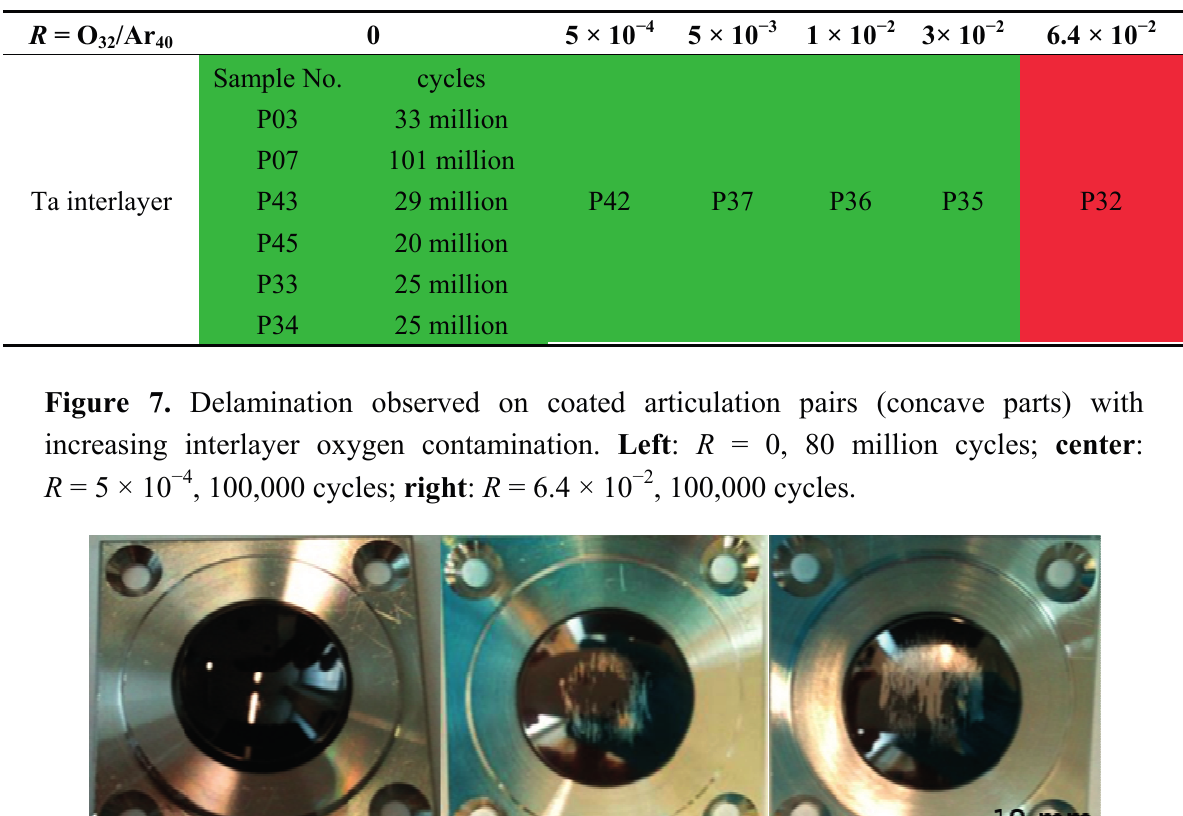
Table 1. Implants coated in this study and resultant interlayer stability. Only samples with R = 0 were found to be stable up to high cycle numbers in the simulator tests, whereas only samples with R = 6.4 × 10 − 2 (red) exhibited stress-corrosion-cracking behavior.